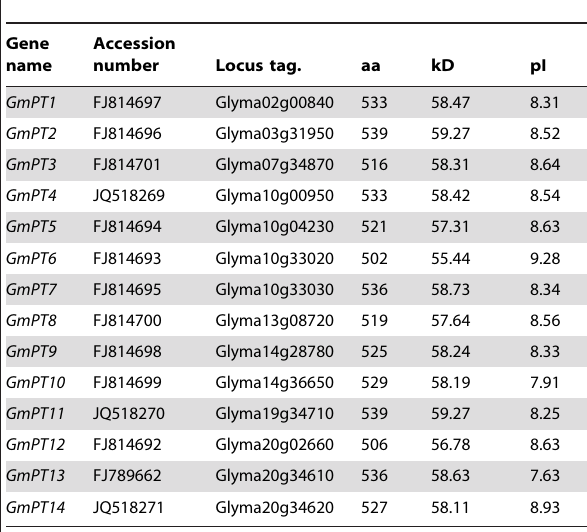
Table 1. Members of Pi transporter genes in the Pht1 family from